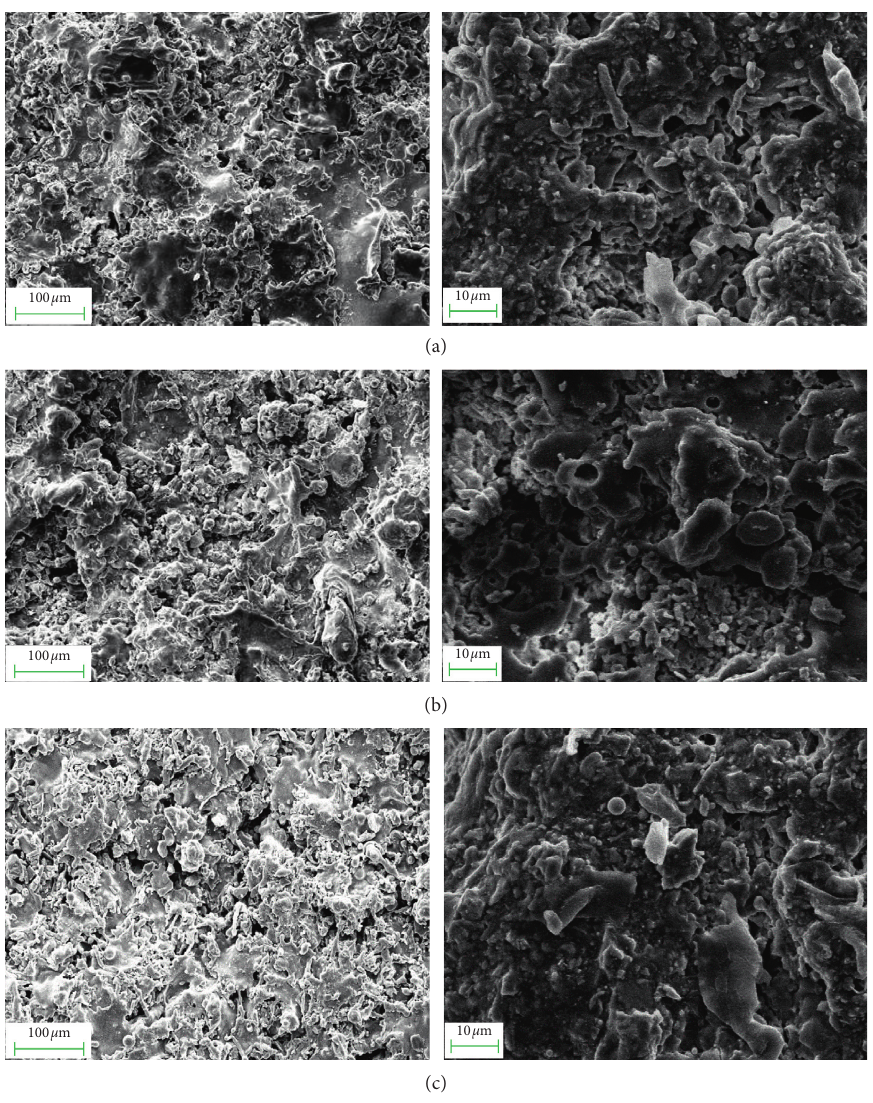
Figure 3: Surface micromorphology of different coatings: (a) 20% Al-80% Zn, (b) 30% Al-70% Zn, and (c) 40% Al-60%